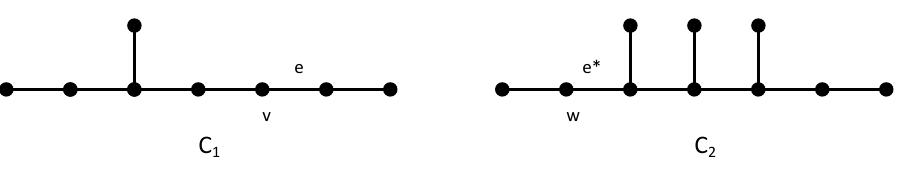
Figure 8: The two caterpillars 𝐶